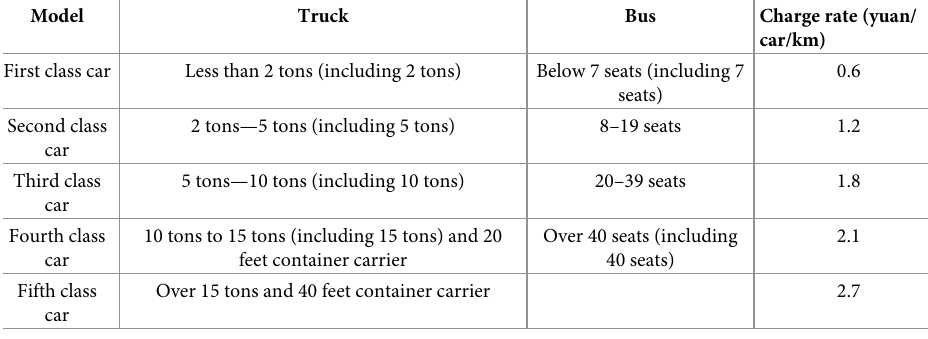
Table 1. Vehicle charging